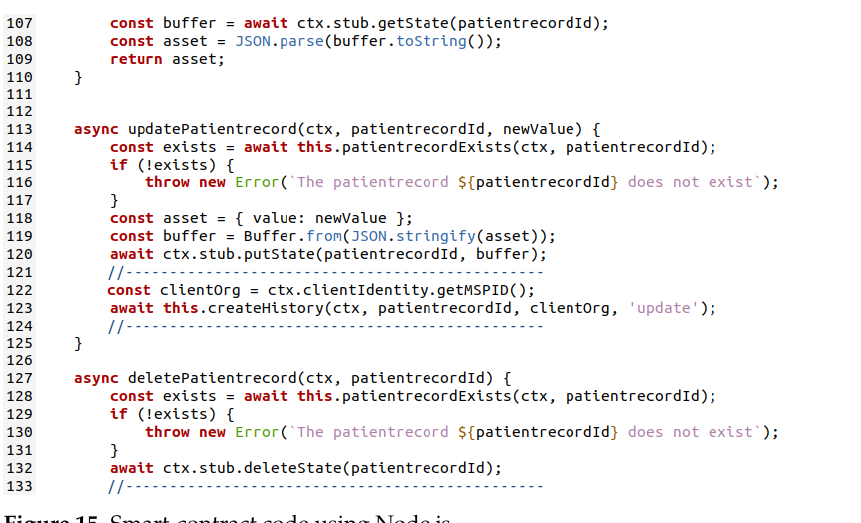
Figure 15. Smart-contract code using Node.js.